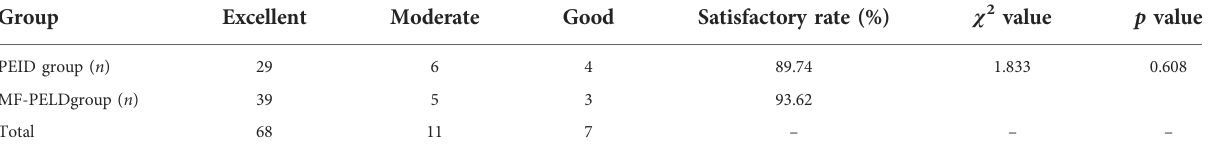
TABLE 3 Modi fi ed MacNab outcome according to group.